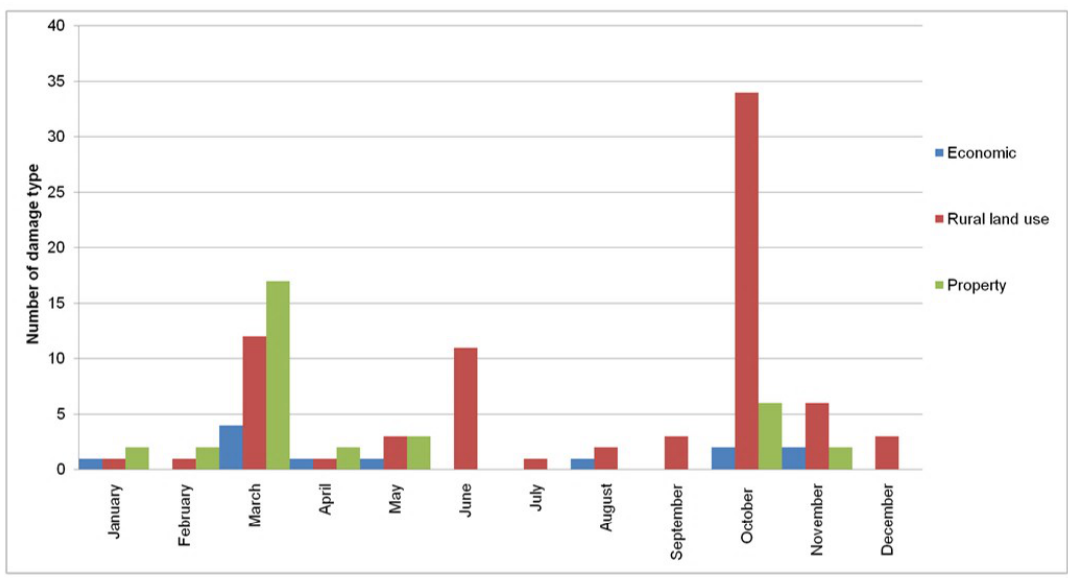
Figure 8. The annual distribution of type of damages in the study area during 1979–2010.